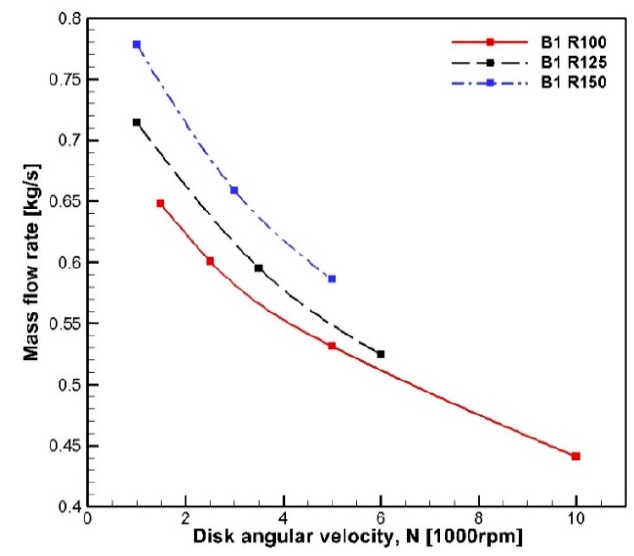
Figure 7. Variation of TT mass flow rate with different disk angular velocities.